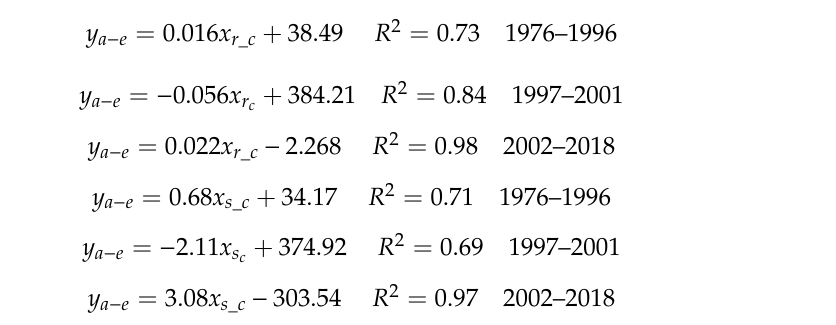
Figure 9. Relationship between the cumulative accretion–erosion area of the estuary and the cumulative annual runoff and sediment from 1976 to 2018. ( a ) for the Yellow River Estuary and the